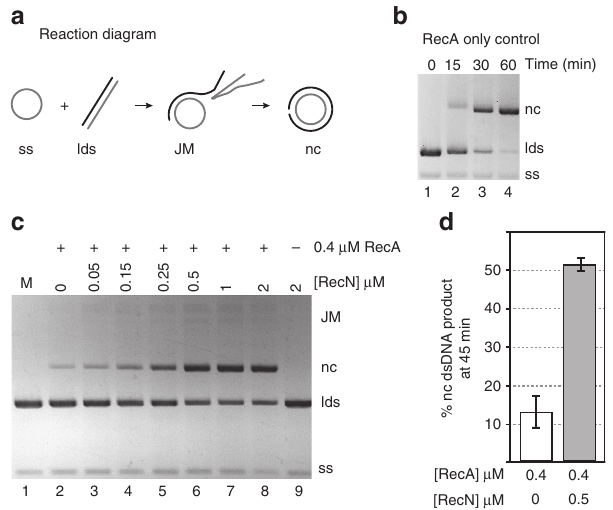
Figure 1 | RecN stimulates RecA-mediated DNA three-strand exchange reactions. ( a ) Schematic of RecA-mediated DNA strand exchange reaction. RecA filaments formed on circular ssDNA (ss) invade and search for homology within linear duplex DNA (lds). The homology between the ssDNA bound by RecA and the duplex DNA is aligned. RecA exchanges these homologous strands forming intermediate, joint heteroduplex DNA molecules (JM). The intermediate joint molecule contains a three-stranded branch point that migrates the length of the molecule until nicked, circular duplex products (nc) are formed. The abbreviations described here (ss, lds, JM and nc) reflect the agarose gel labels used here and in subsequent figures. ( b ) RecA only control (normal conditions).